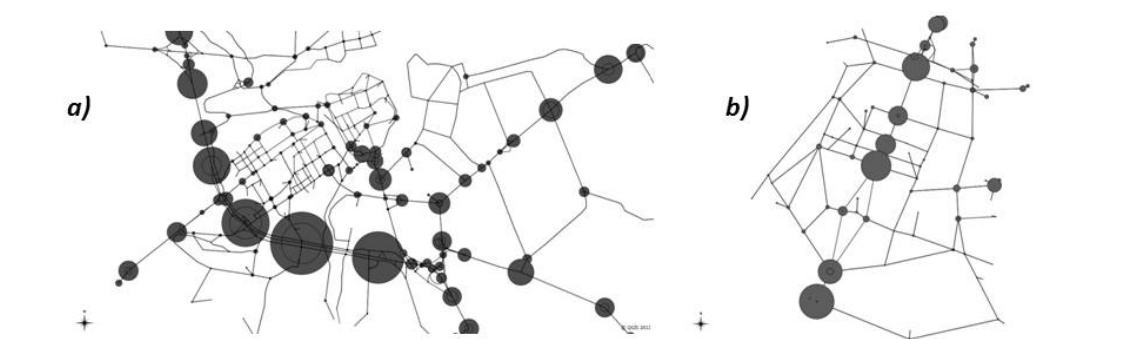
Figure 11. Total CO emissions at intersections (a- Brindisi network, b- Eur